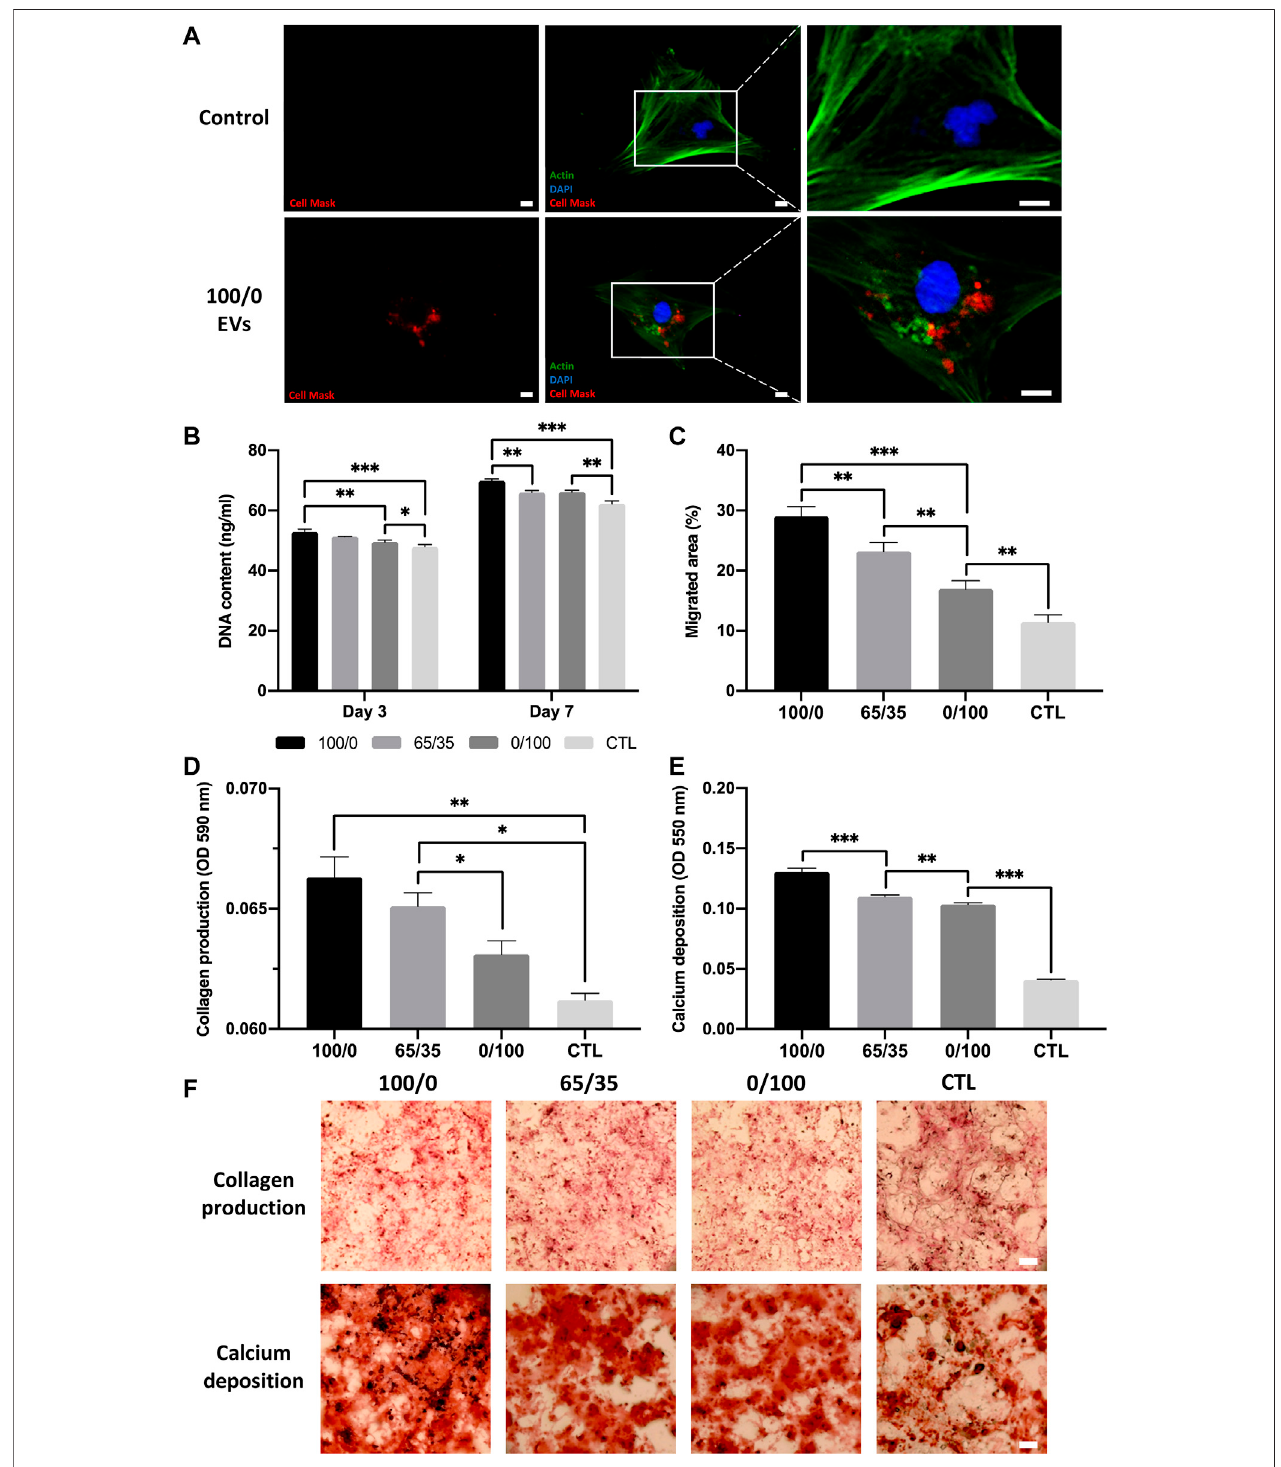
FIGURE5| Thebiological ef fi cacyofhydrogel-released EVs onhBMSCs behaviour.Thein fl uence onhydrogel-released EVs on hBMSCs (A) EVcell uptake. Scale bar=20 μ m, (B) proliferation, (C) migration, (D,F) collagenproduction,and (E,F) calciumdeposition.Blackstainingindicatesmineralnodules.Scalebar=100 µm.Data are expressed as mean ± SD ( n = 3). * p ≤ 0.05, ** p ≤ 0.01, and *** p ≤ 0.001.